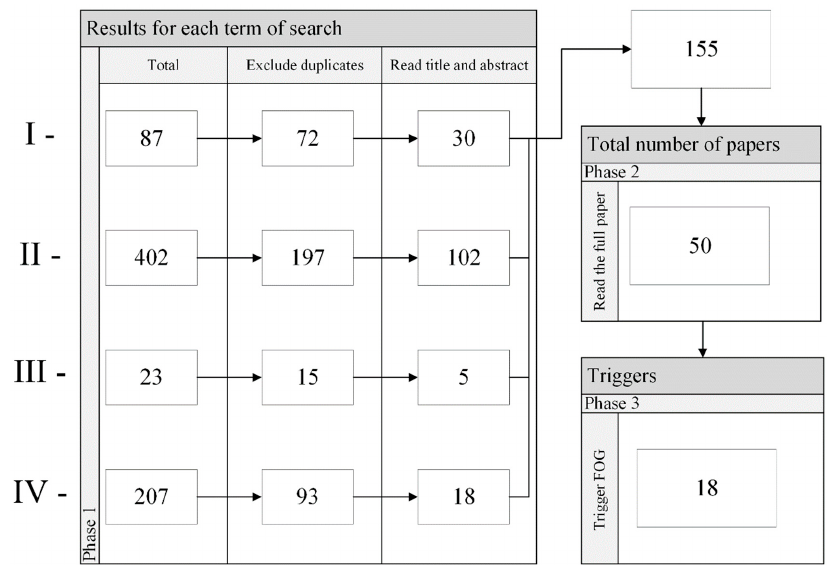
Figure 1. Flow diagram depicting the strategy adopted for literature review. The search terms are identified by I, II, III and IV.